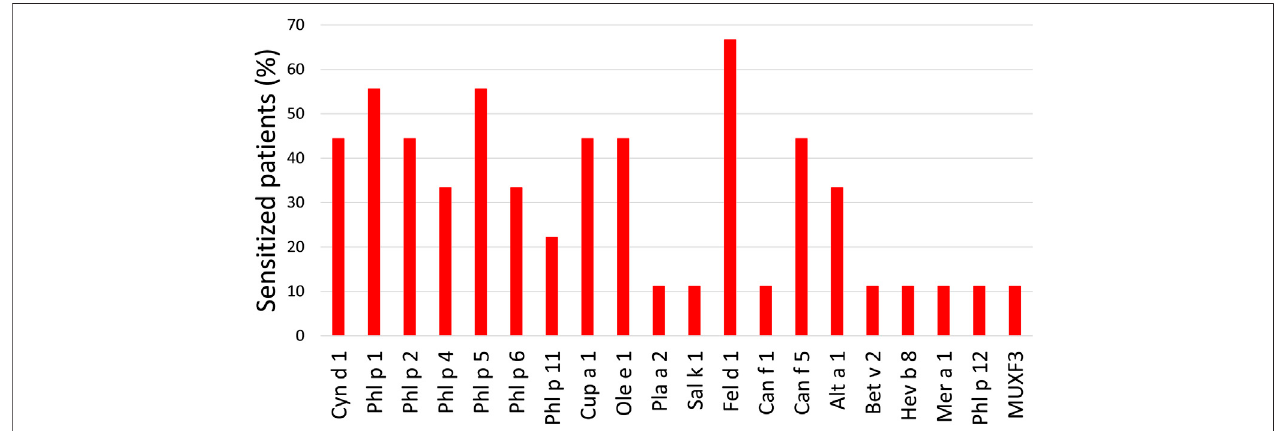
FIGURE 1 | Percentage of allergic patients sensitized to each allergen. Cyn d: Cynodon dactylon (Bermuda grass); Phl p: Phleum pratense (timothy); Cup a: Cupressusarizonica (cypress);Olee: Oleaeuropaea (olive);Pla a: Platanusacerifolia (Londonplanetree); Salk: Salsolakali (saltwort); Feld: Felis domesticus (cat);Canf: Canis familiaris (dog); Alt a: Alternaria alternata ( Alternaria plant rot fungus); Bet v: Betula verrucose (European white birch); Hev b: Hevea brasiliensis (latex); Mer a: Mercurialis annua (annual mercury); MUXF3: